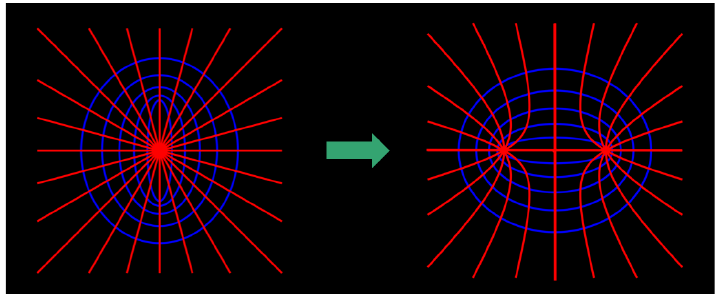
Figure 4. Illustration of circle-Cassinian transformation that converts radial lines into hyperbolas that are orthogonal to the Cassinian ovals and converts vertical confocal ellipses into horizontal confocal